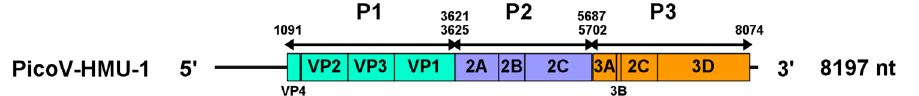
Figure 2. Genome organization of the PicoV-HMU-1 sequence.